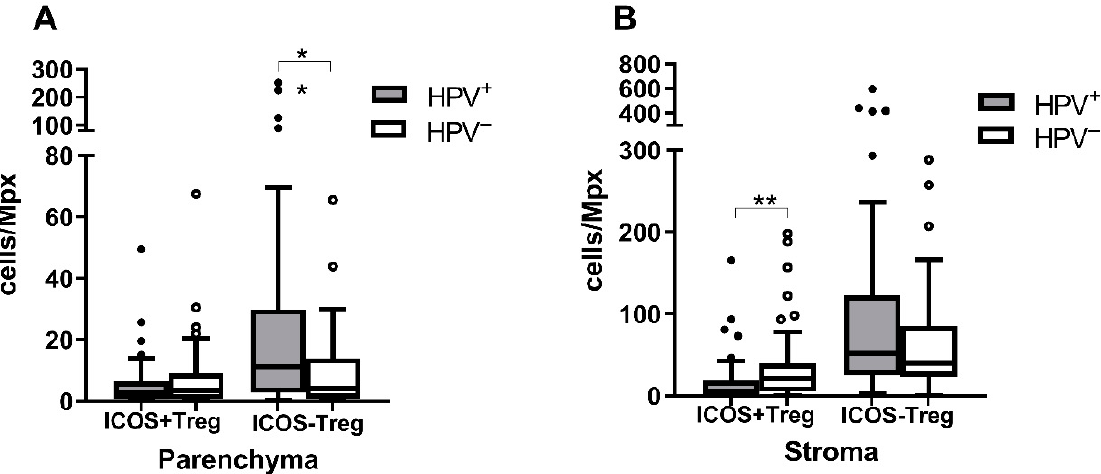
Figure 3. Comparison of the ICOS + and ICOS − Treg levels in the HPV + and HPV − tumors. The num- bers of Treg cells with or without ICOS production per Mpx were compared in ( A ) the parenchyma and ( B ) the stroma of the tumors of different etiology. Higher ICOS + Treg levels were observed in both the parenchyma and stroma of the HPV − tumors, with the difference being significant for the stroma. Higher ICOS − Treg numbers were detected again in both the parenchyma and stroma of HPV + tumors, with the difference being significant for the parenchyma. * p ≤ 0.05, ** p ≤ 0.01, Mann– Whitney U test.